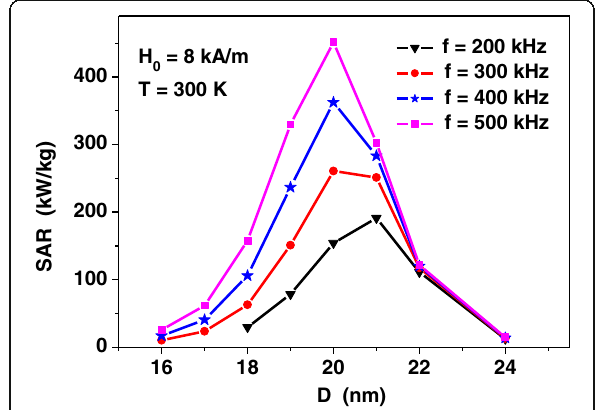
Fig. 2 The specific absorption rate of non-interacting assembly of iron oxides nanoparticles, obtained by means of Eqs. (1) and (2), as a function of average particle diameter at different frequencies of the alternating magnetic